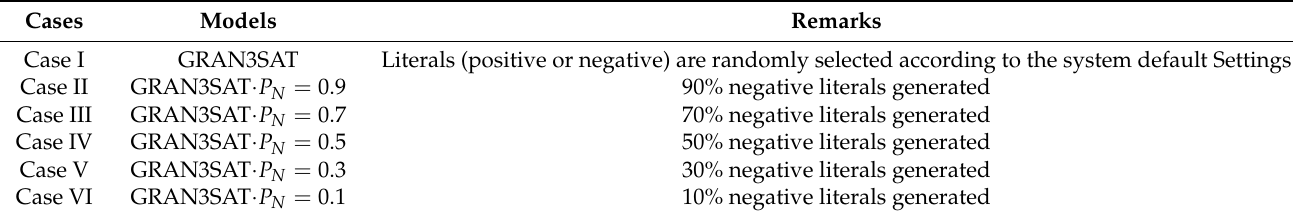
Table 9. Different literal proportions for GRAN3SAT models.